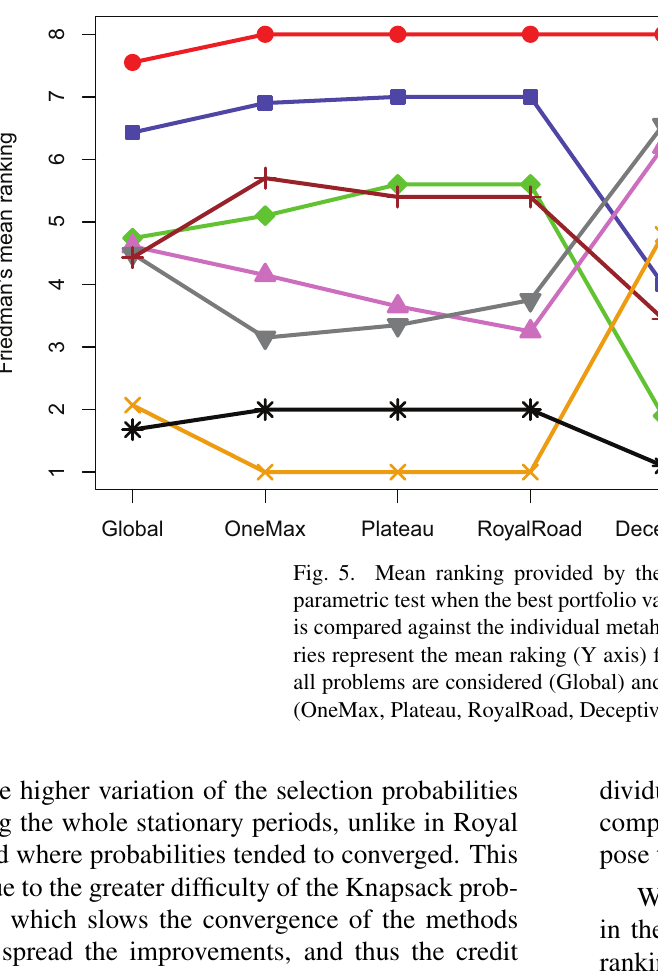
Algorithm portfolio based scheme for dynamic optimization problems